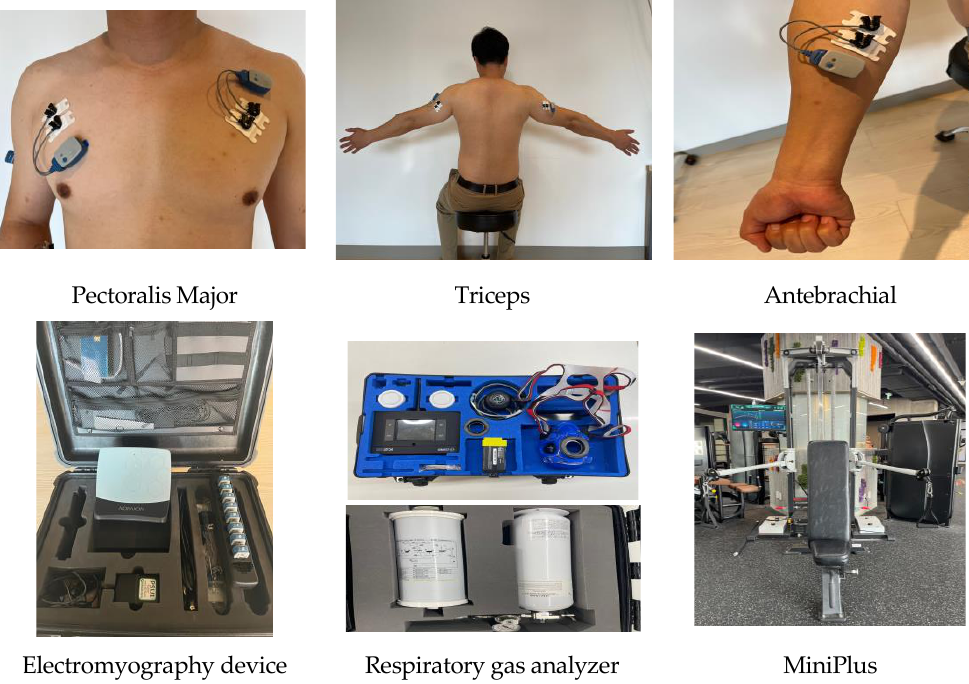
Figure 2. The sites of electrode attachment for the electromyography (EMG) and the devices used in this study.